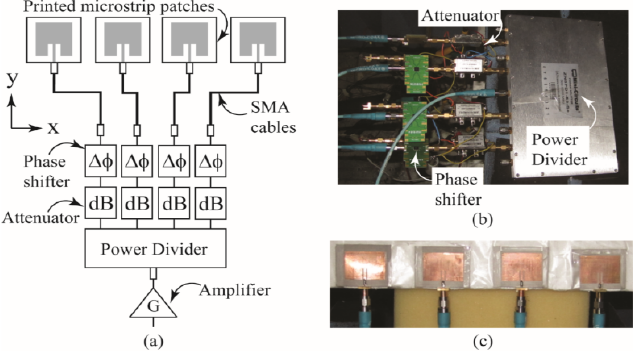
Figure 4. ( a ) Topology of the four-element beamforming array, ( b ) a picture of the power divider, voltage-controlled phase shifters and voltage-controlled attenuators used for measurements and ( c ) a picture of the microstrip patch elements used for attachment to conformal surfaces.